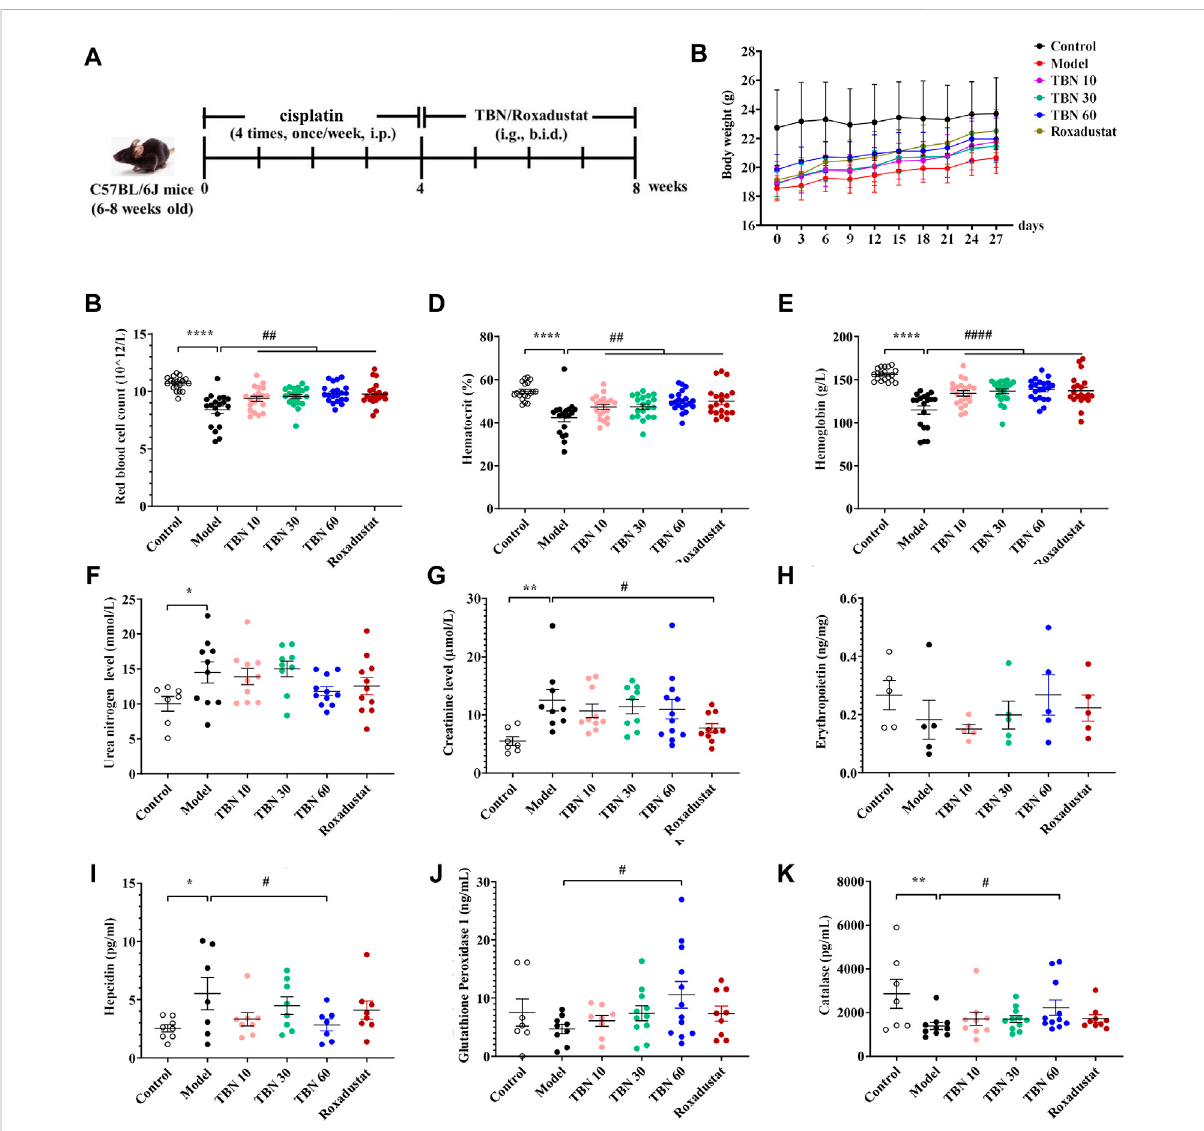
TBN ameliorates renal anemia in CDDP-induced mice. (A) Experimental fl ow chart, (B) Body weight. Blood measurements including (C) RBC count, (D) HCT and (E) Hb in C57BL/6J mice [ n = 19 – 21 for each group in Figure (A – E) ]. Levels of (F) Urea nitrogen level, (G) Creatinine after TBN treatmentinC57BL/6Jmice.Levelsof (H) EPO, (I) hepcidin,subsequenttoTBNtreatmentinC57Bl/6Jmice.TheeffectofTBNin (J) GPx, (K) CAT( n = 7 – 8 for control group in Figure (F – G) , (I – K) ; n = 7 – 12 for the other group in Figure (F – G) , (I – K) ; n = 5 for each group in Figure (H) . Data are presented as mean ± SEM; * p < 0.05; ** p < 0.01; **** p < 0.0001; vs. Control; # p < 0.05; ## p < 0.01; #### p < 0.0001 vs. vehicle-treated CDDP group. CDDP, cisplatin; RBC count, red blood cell count; HCT, hematocrit; Hb, hemoglobin; EPO, Erythropoietin; CAT, catalase; GPx, glutathione peroxidase. Model: vehicle-treated CDDP